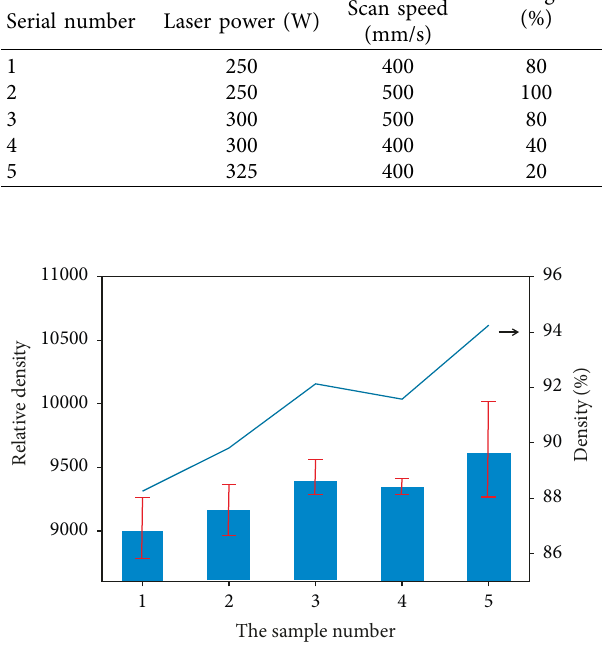
Figure 2: Schematic diagram of relative density and density evolution of sample numbers under different printing